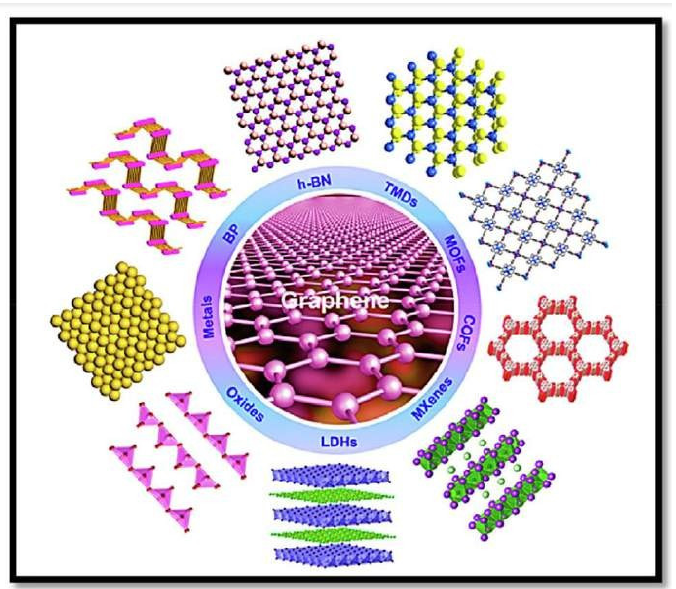
Figure 6. Illustration of various types of two-dimensional nanomaterials for electrode materials in supercapacitors. Reproduced with permission from [64].